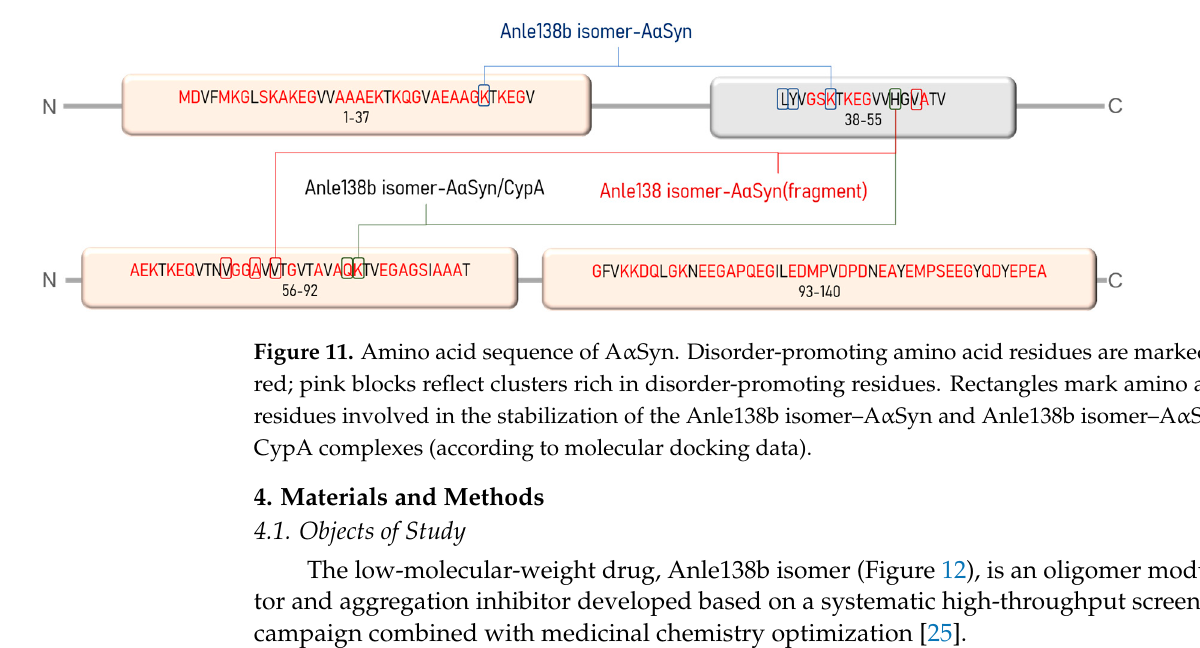
Figure 11. Amino acid sequence of AαSyn. Disorder -promoting amino acid residues are marked in red; pink blocks reflect clusters rich in disorder-promoting residues. Rectangles mark amino acid residues involved in the stabilization of the Anle138b –AαSyn and Anle138b–AαSyn– CypA complexes (according to molecular docking data).